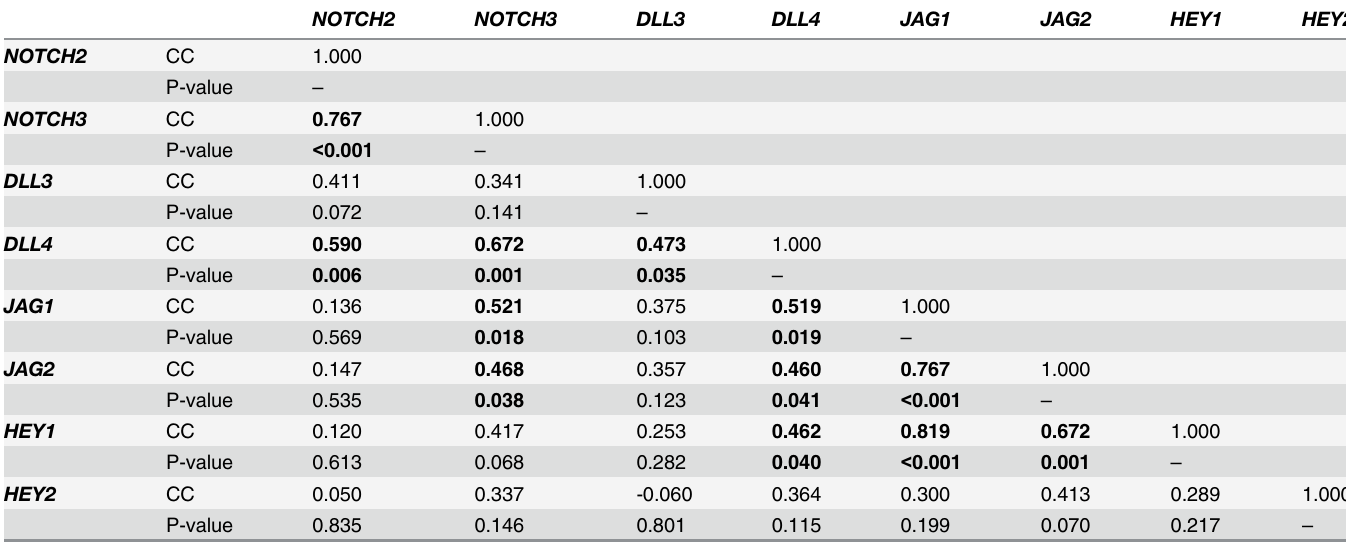
Table 4. Notch signaling pathway pair-wise mRNA co-expression analysis in normal